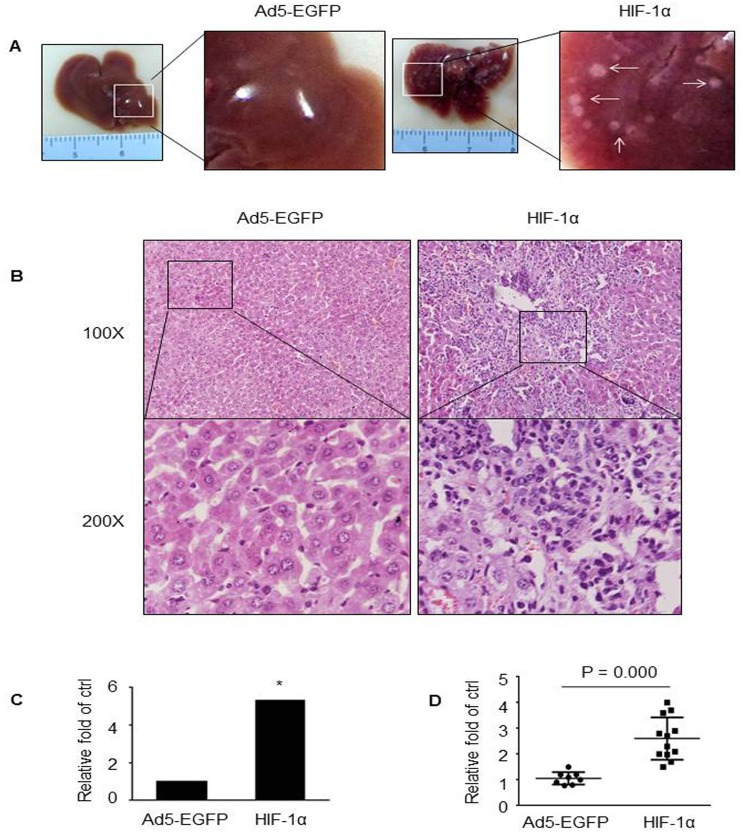
HIF-1α overexpression promoted liver metastasis in vivo.Representative photographic pictures (A) and H&E staining (B) of liver of BALB/c mice five weeks after subsplenic injection of HT29 cells transduced with Ad5-HIF-1α or control viruses. White arrows indicated metastatic nodules. (C) The comparison of liver metastases between HT29-Ad5-HIF-1α mice (N = 12) and control mice (N = 8). *P < 0.05. (D) Confirmation of the overexpression of HIF-1α from metastatic nodules in mice injected with Ad5-HIF-1α by qPCR, compared with those injected with control viruses.